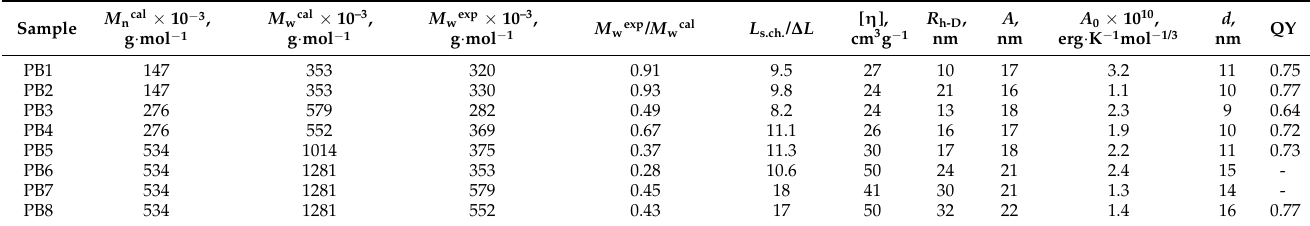
Table 3. Molar masses, hydrodynamic, structural conformationalcharacteristics, and quantum yields of the studiedPBs in chloroform. ncal × 10 − 3 , Sample M g · mol − 1